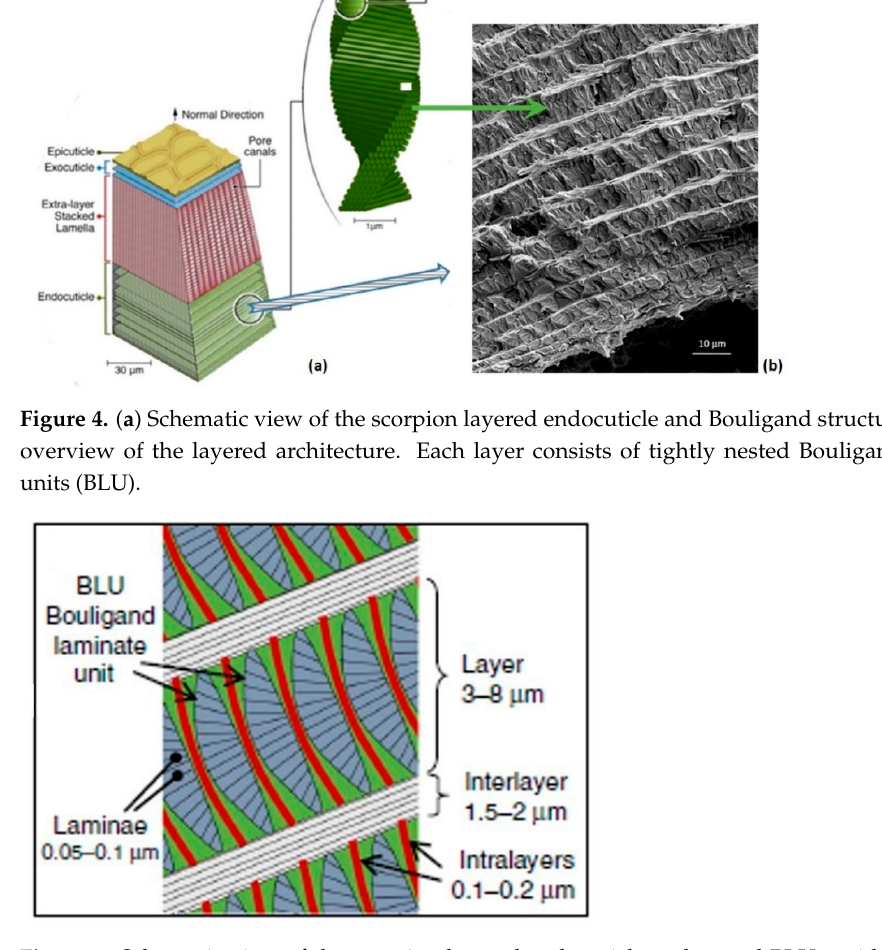
Figure 5. Schematic view of the scorpion layered endocuticle and nested BLUs, with definitions and scaling.